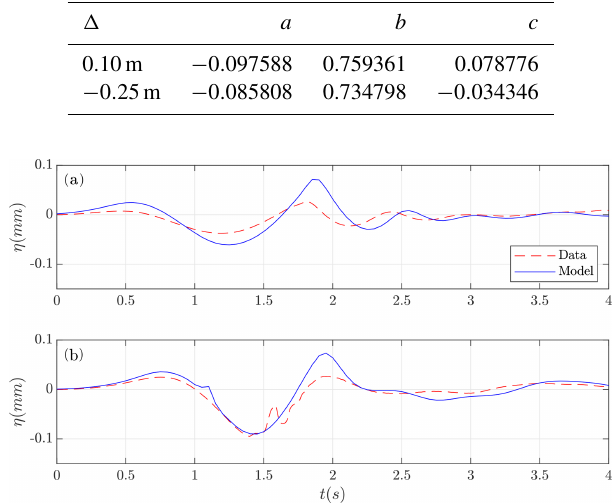
Figure 12. Subaerial test case. Lab-measured water height (red) and numerical time series (blue) at wave gauges (a) WG1 and (b) WG2.